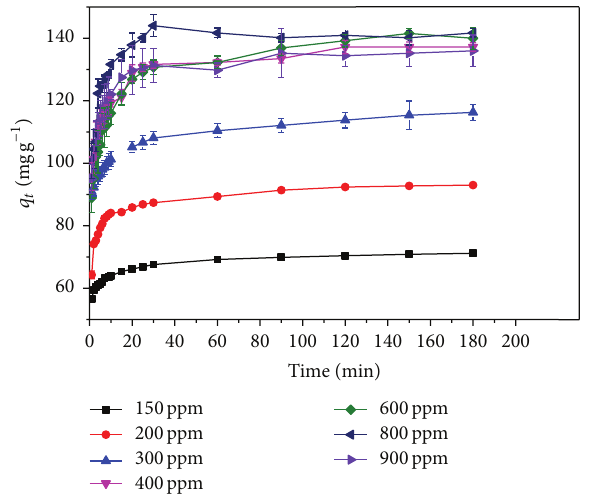
Figure 6: Effect of initial dye concentration on the adsorption of AB at 25 ∘ C. Adsorption condition: initial AB concentration: 150– 900 mgL −1 , temperature = 25 ± 1 ∘ C, mass of adsorbent = 2.0g, volume of solution = 1000 mL, stirring speed = 300 rpm, and pH of dyes solution = 7.